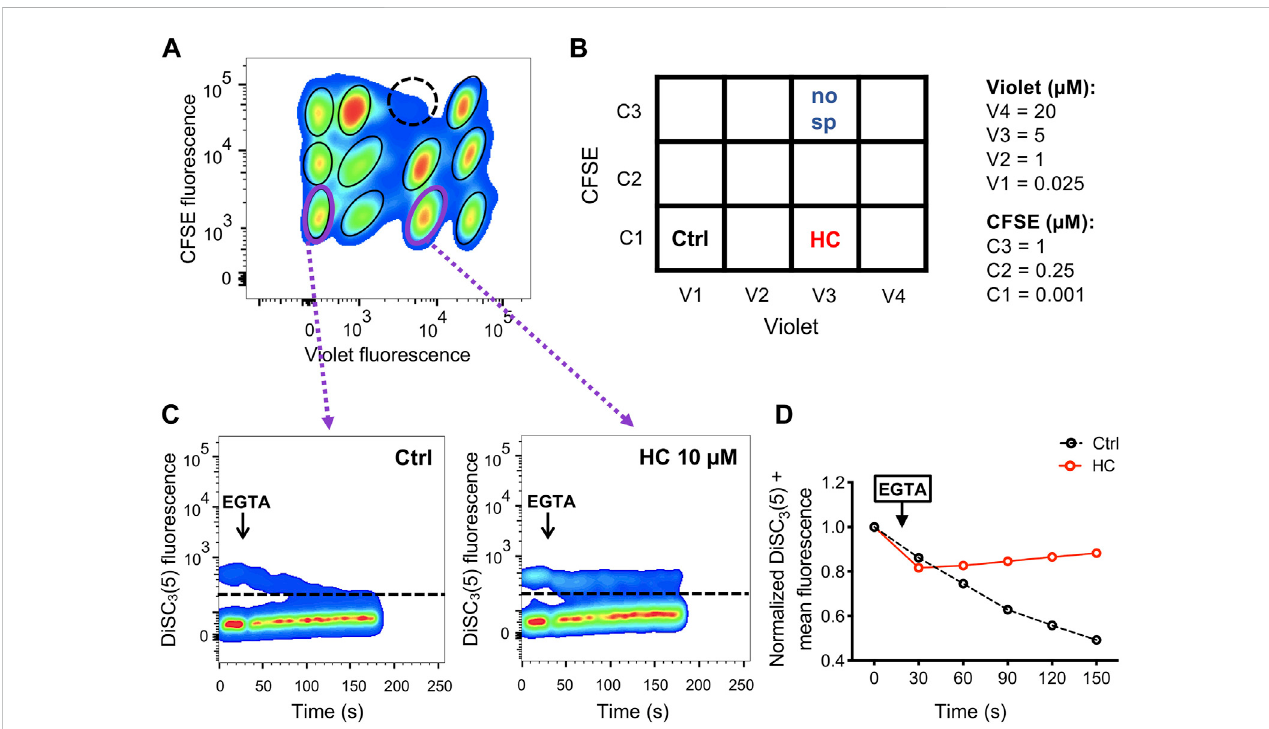
FIGURE 5 (A) Representative 2D dot plot of CellTrace ™ Violet vs. CellTrace ™ CFSE fl uorescence of a 4 × 3 matrix, where the population of sperm with each dye combination/signature was de fi ned. As an additional control of proper identi fi cation in the matrix, in one well sperm were not added (dashed-line circle). (B) Diagram showing thearrangementofcompounds (HC:CatSper inhibitor; Ctrl:NC+ DMSO vehicle; no sp: no sperm wereadded) within the4× 3matrix. The dyeconcentrationineachwellisdepictedasadouble-entrytable. (C) Representative2DdotplotofDiSC 3 (5) fl uorescencevs.time(seconds)analysisfor the positive (HC) and negative (Ctrl) controls. The addition of 3.5 mM EGTA (black arrow) induced a decrease in the population of sperm with high DiSC 3 (5) fl uorescence due to Em depolarization in the NC control condition (with only vehicle) but not in sperm that were incubated with 10 µM HC-056456. The population of sperm that responds by decreasing the Em was established in the NC control condition and extrapolated to the other conditions (dashed line). Sperm cells above the dashed line [higher DiSC 3 (5) fl uorescence] were arbitrarily identi fi ed as DiSC 3 (5) +. (D) DiSC 3 (5) fl uorescence mean was determined in thesperm populationwith higher DiSC 3 (5) fl uorescence:DiSC 3 (5)+ [dashed line in (C) ]before (time =0 s) and after (black arrow) additionof 3.5 mM EGTA. In each condition, the fl uorescence mean was normalized to the basal fl uorescence (0